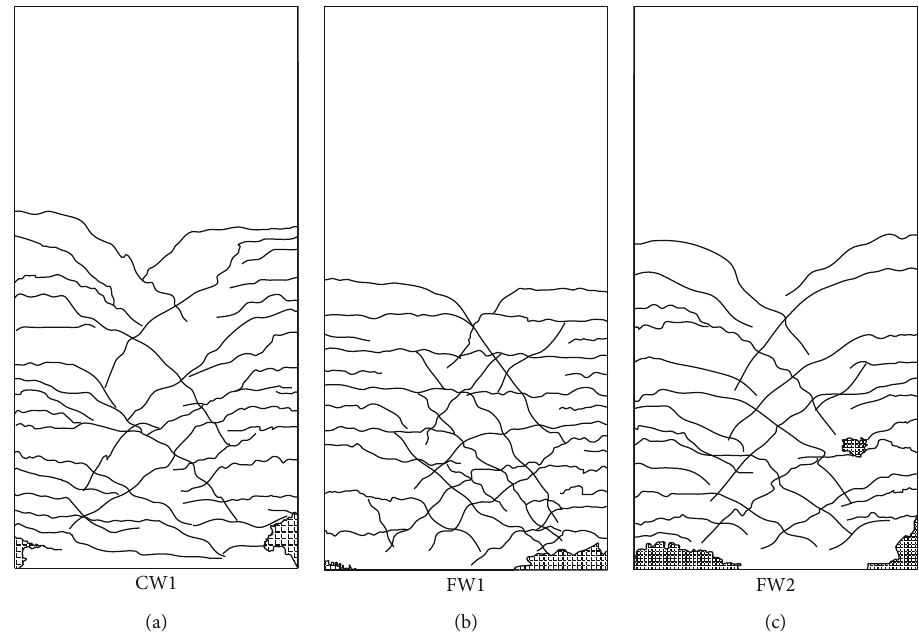
Figure 5: Crack distributions on specimens.